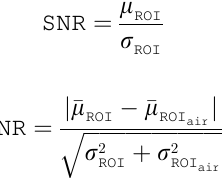
The UQI measures the intensity similarity between two images, and its value ranges [0, 1]. A UQI value close to 1 indicates a better level of similarity between the reconstructed and true images. We chose two ROIs: The whole ACR phantom body on slices 10 and 50. We calculated the UQI scores for all three methods under comparison. Image noise—SNR and CNR. To evaluate the quantitative noise level of the reconstructed images, we chose two different metrics, SNR and CNR. The definitions are as follows.